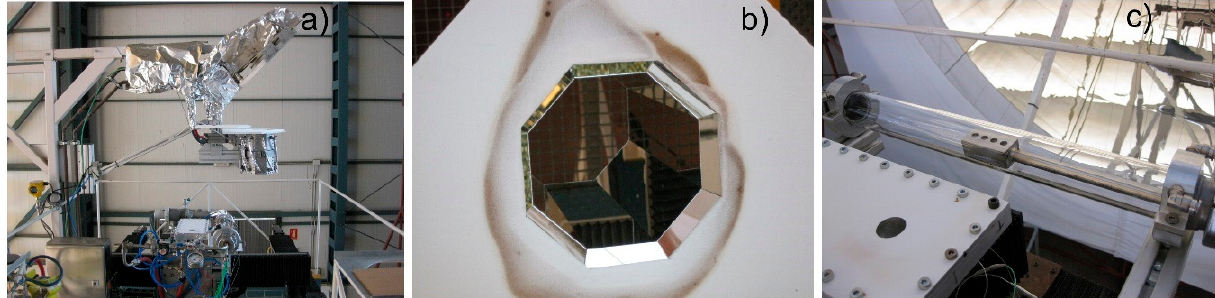
Figure 1. Experimental setup: general view ( a ), top view of the octagonal temperature homogeniser ( b ), and reactor tube containing sample holder ( c ).